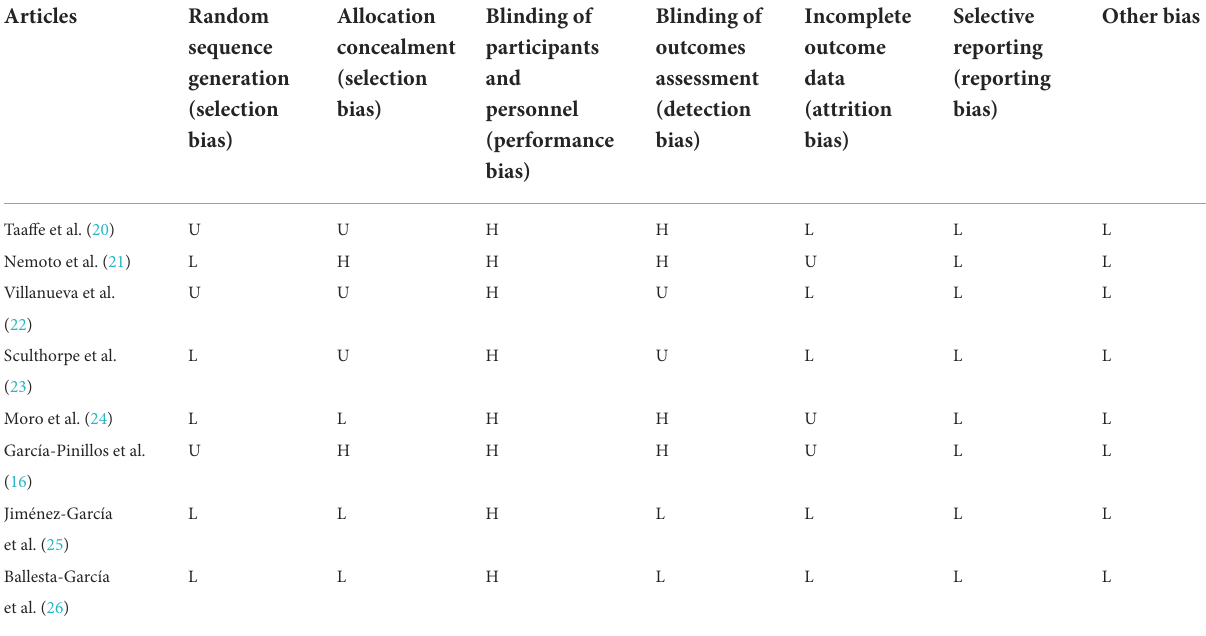
TABLE 1 Assessment of risk of bias for included